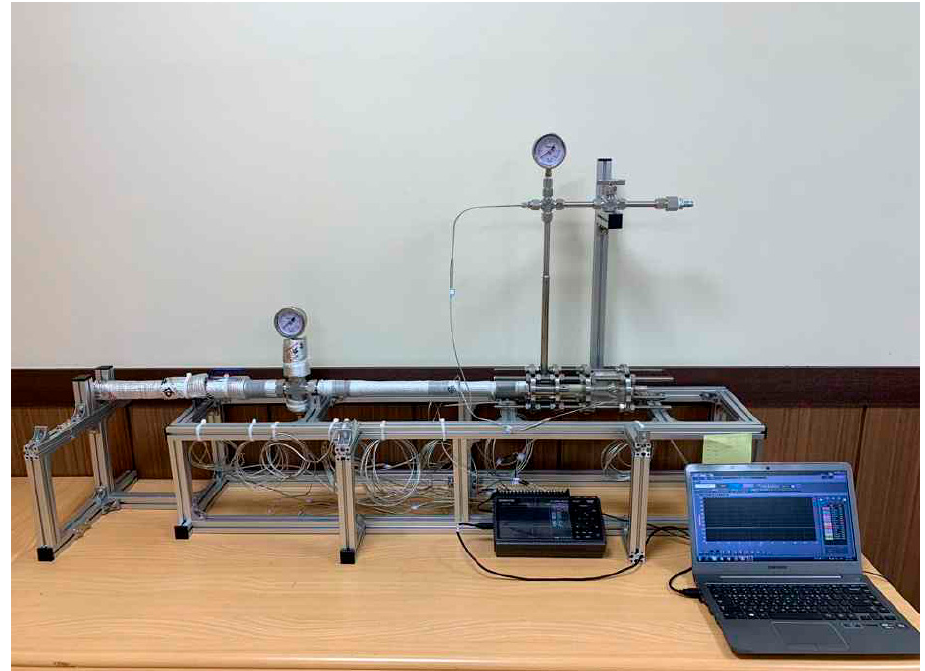
Figure 4. Photograph of the experimental apparatus for the vortex tube.